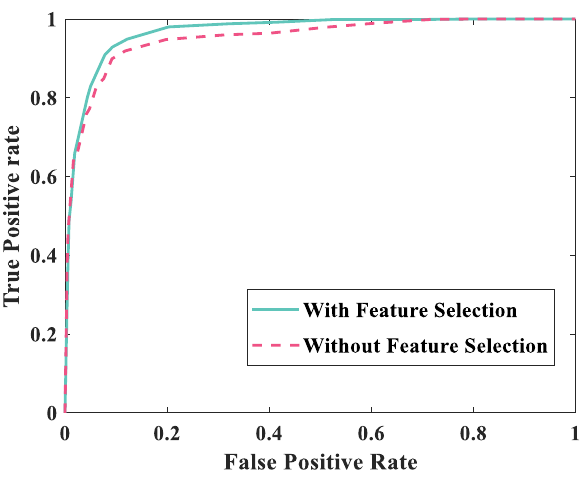
Figure 7. Receiver operating characteristic (ROC) curve of the system.